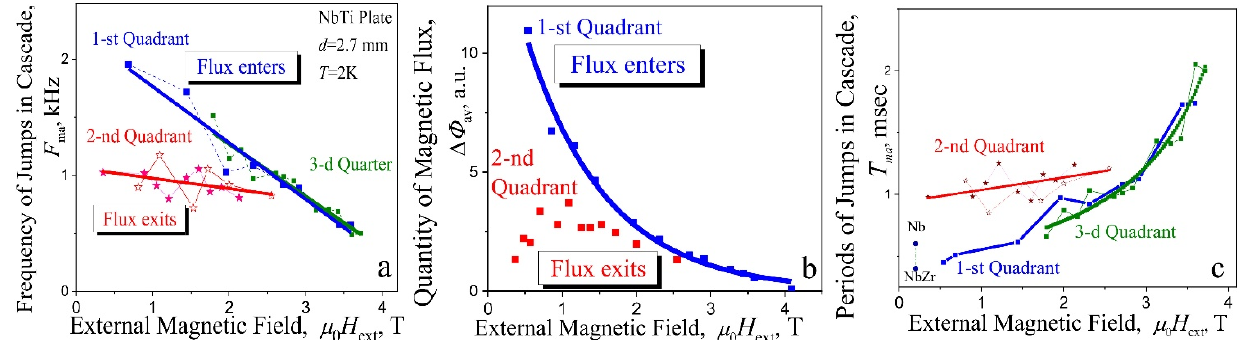
Figure 9. ( a ) The frequencies F ma with the maximal amplitude in specters of signals vs magnetic field for different quadrants. ( b ) Quantity of the magnetic flux enters (1st quadrant) and exits (2nd quadrant) at avalanches vs magnetic field; ( c ) the period T ma = 1/ F ma between jumps in cascade vs magnetic field for different quadrants; d = 2.7 mm, T = 2 K. Symbol ( ● )—the time during which the avalanche flux front travels a distance of 3 mm in Nb and NbZr at 1.6 K and at magnetic field µ 0 H ext = 0.2 T [14].